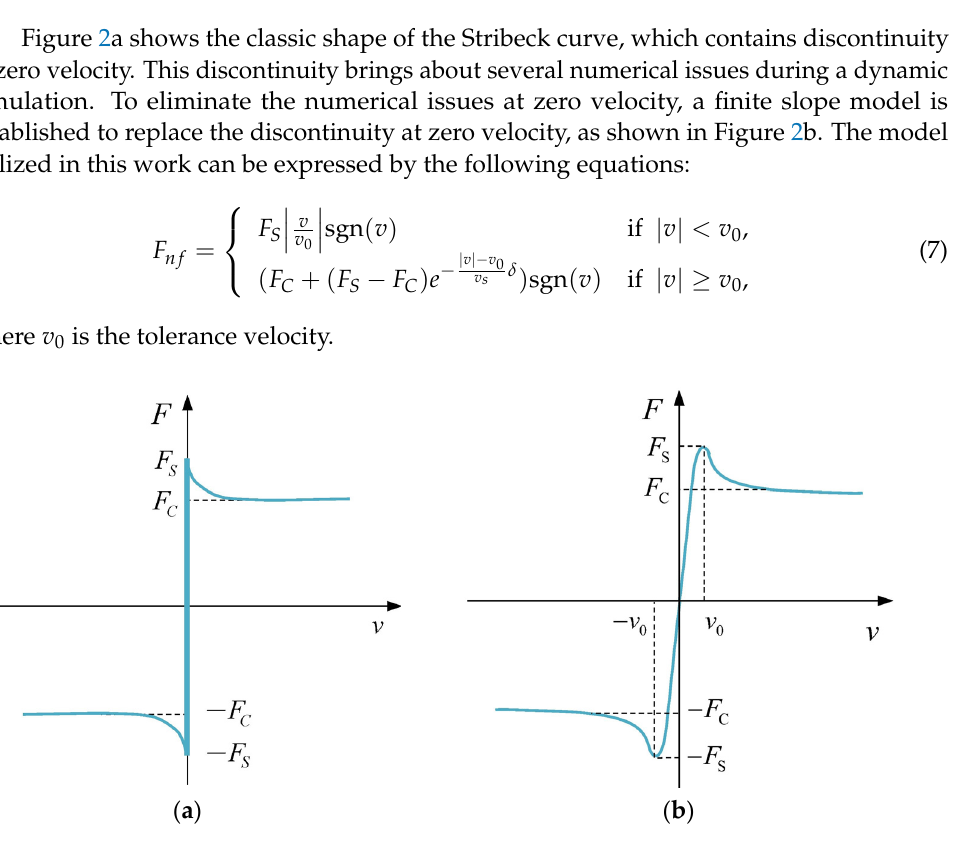
Figure 2. Representation of Stribeck curves: ( a ) The classic Stribeck curve; ( b ) Stribeck curve without discontinuity.